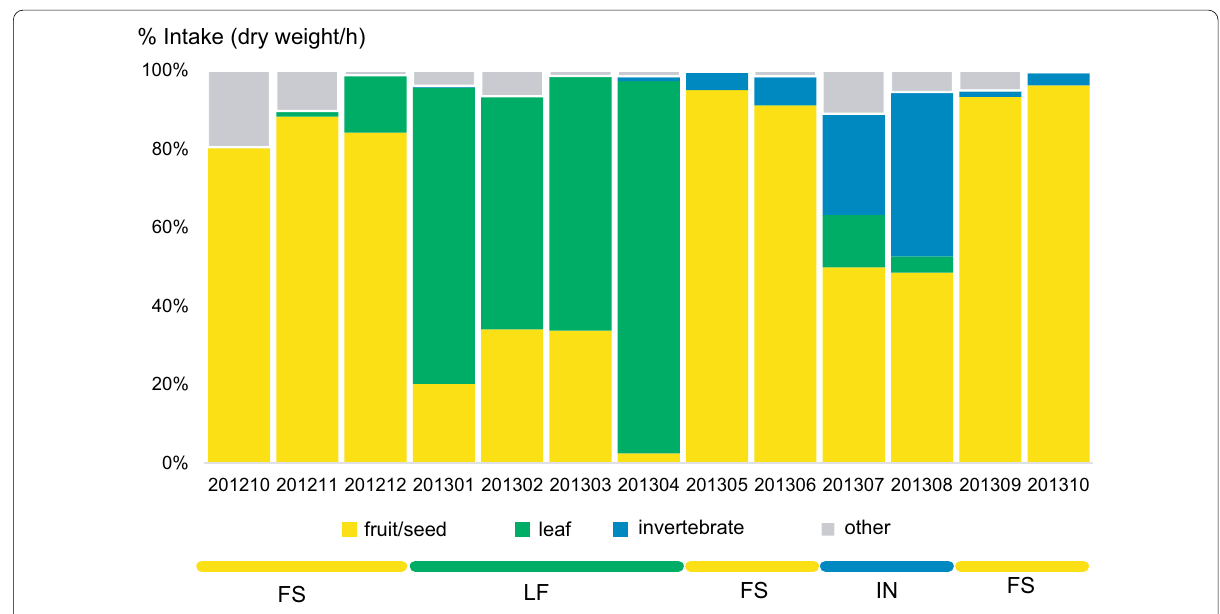
Fig. 2 Monthly variations in the diet of Japanese macaques and the classification of the three dietary seasons. FS fruit/seed-feeding; LF leaf-feeding; IN invertebrate-feeding seasons